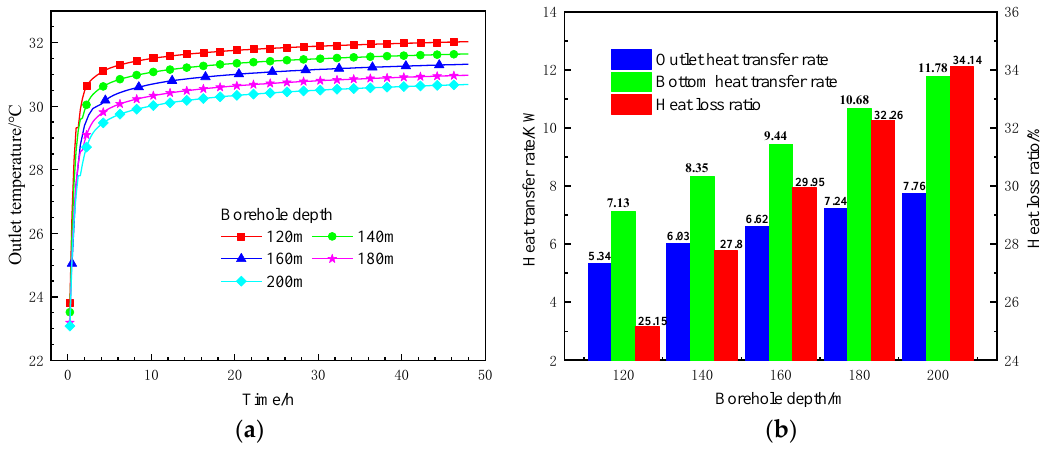
Figure 17. Sensitivity of outlet temperature and heat transfer rate to borehole depth. ( a ) Sensitivity of outlet temperature to borehole depth. ( b ) Sensitivity of heat transfer rate and heat loss ratio to borehole depth.